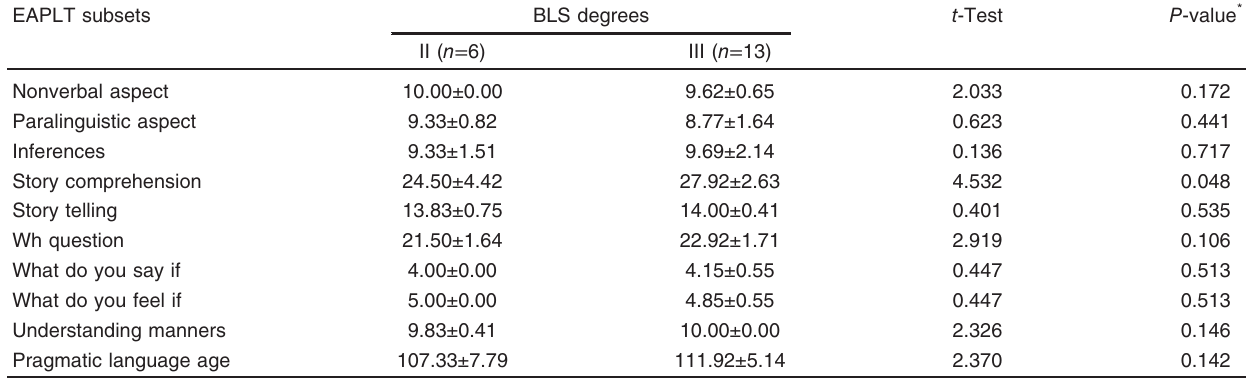
Table 9 Relation between stuttering severity measured by Bloodstein degree and pragmatic language development in children in age group II (6 years 1 month 1 day to 7 years 12 months 31 days) using independent sample t -test EAPLT subsets